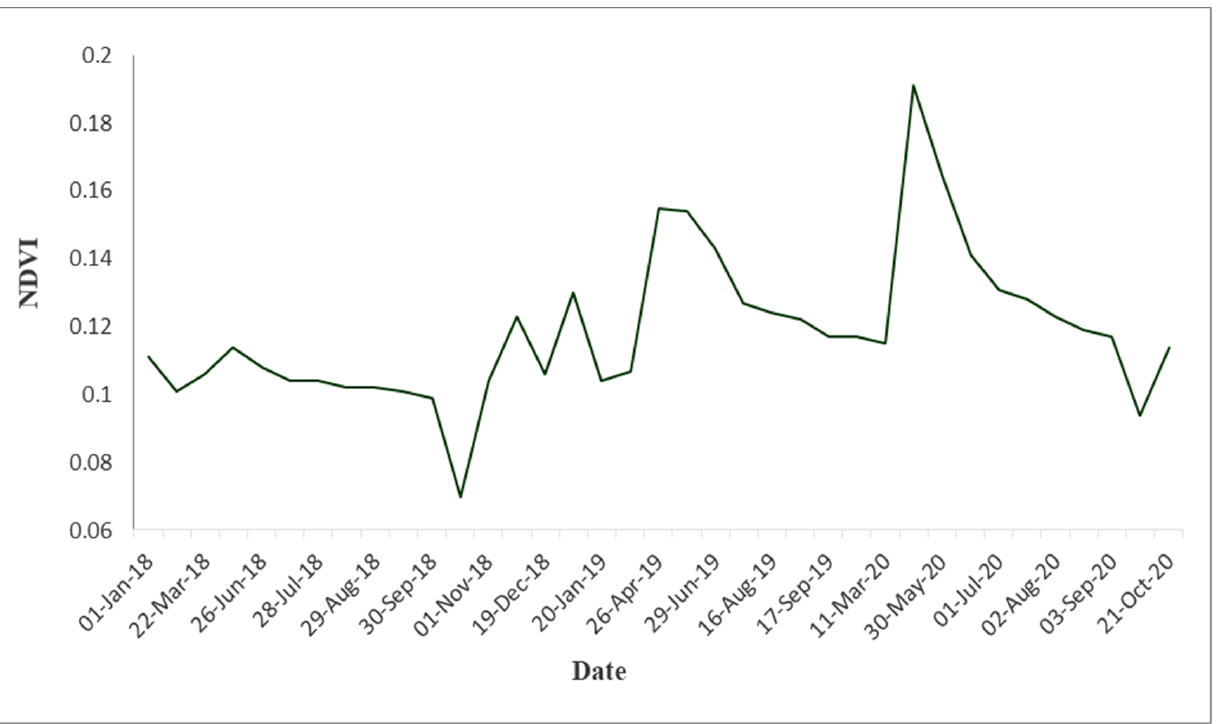
Figure 5. The NDVI time series profile of Landsat 8 images for the period 1 January 2018 to 21 October 2020.